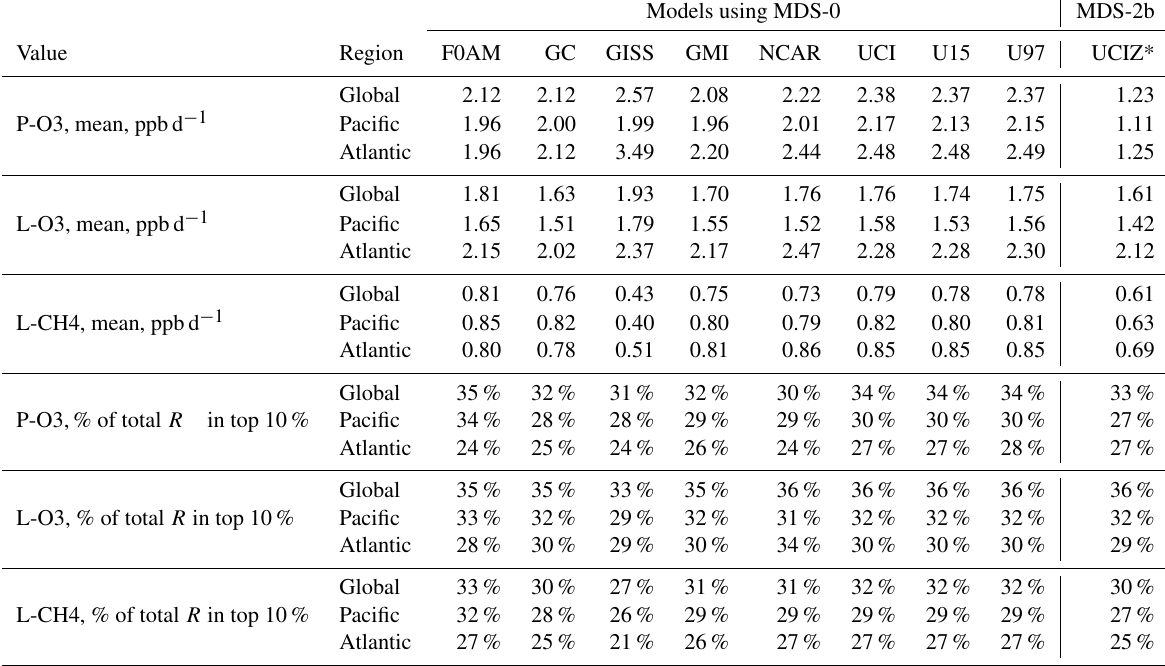
Table 2. Reactivity statistics for the three large domains (global, Pacific, and Atlantic).